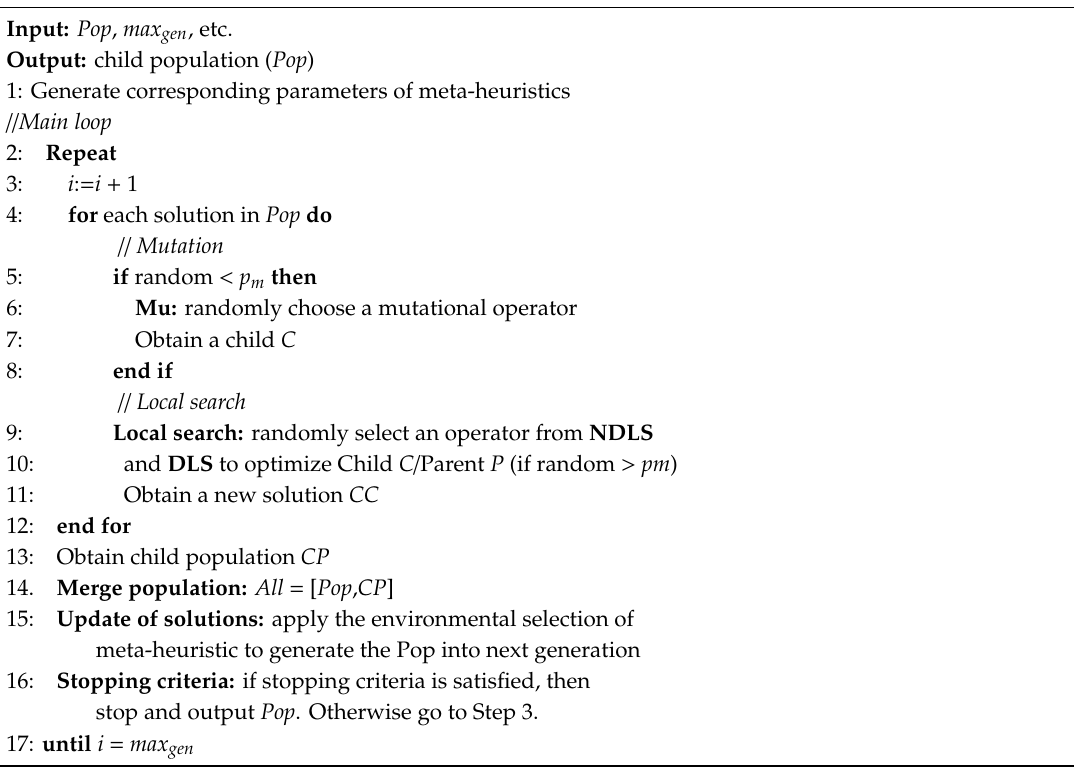
Algorithm 1 General framework of MOEAs for